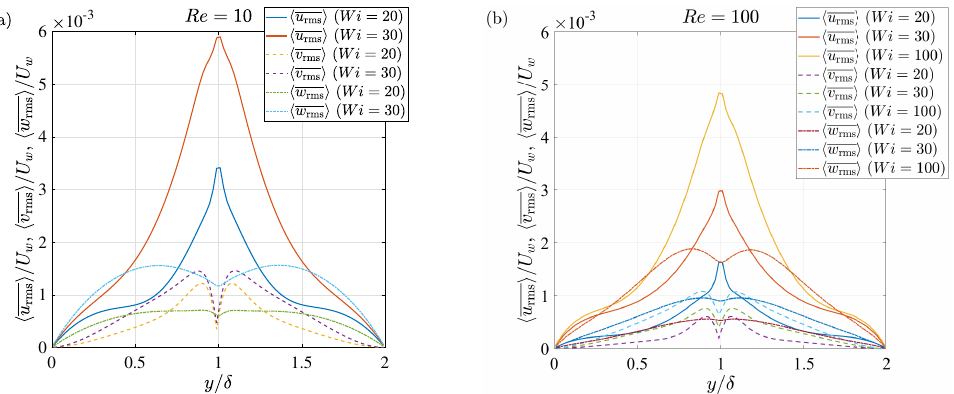
Figure 6. RMS velocity u i rms profiles for increasing Wi at each Reynolds number, ( a ) Re = 10 and ( b ) Re =